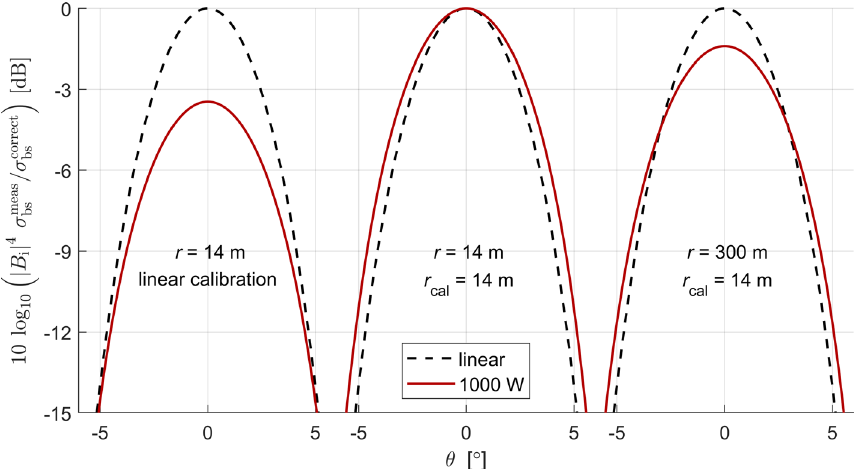
Figure 5. Illustration of nonlinear loss in the sound beam, using the numerical results for 200 kHz, 1000 W. Left: Two-way intensity beam pattern at 14 m range, with and without correction for nonlinear loss in the forward propagating wave. Centre: Two-way intensity beam pattern at 14 m range, corrected for nonlinear loss upon both measurement and calibration at the same range. Right: Two-way intensity beam pattern at r = 300 m range, corrected for nonlinear loss upon measurement and upon calibration at r cal = 14 m Dashed curves indicate the two-way intensity beam pattern ( h , u )| 4 for the 200 kHz echosounder without accounting | B i for nonlinear loss, cf. equation (4). The full-drawn curves show the same two-way beam pattern divided by